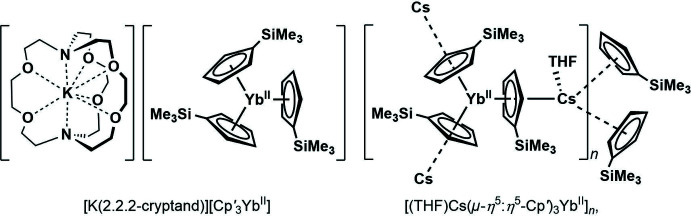

CHEMDRAW (Mills, 2006 ▸) representation of [K(2.2.2-cryptand)][Cp′3YbII] (left) and [(THF)Cs(μ-η5:η5-Cp′)3YbII]n, 1, (right).